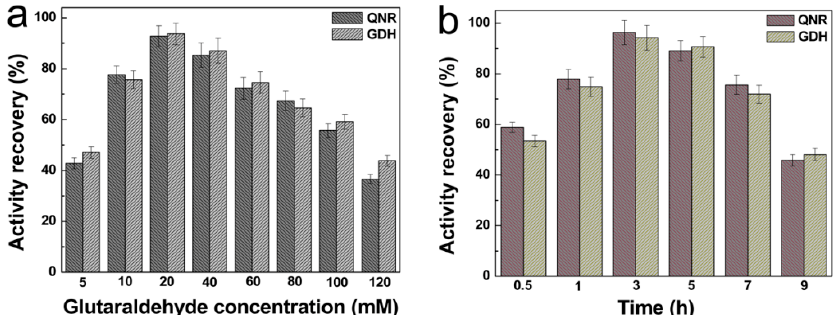
Figure 6. Effect of GA concentration ( a ) and cross-linking time ( b ) on the activity recovery of QNR and GDH in the magnetic combi-CLEAs. The measurements were performed in triplicate.